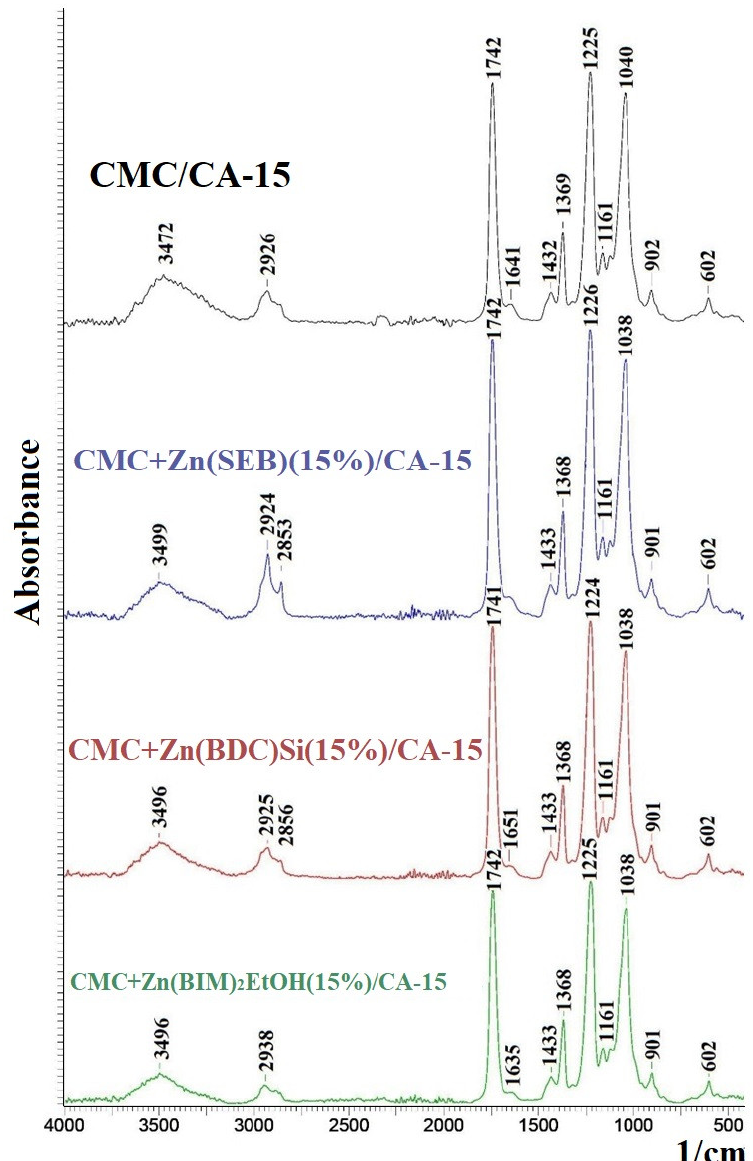
Figure 10. FTIR spectra of the cross-linked supported CMC-based membranes, modified with 15 wt.% Zn-based MOFs.